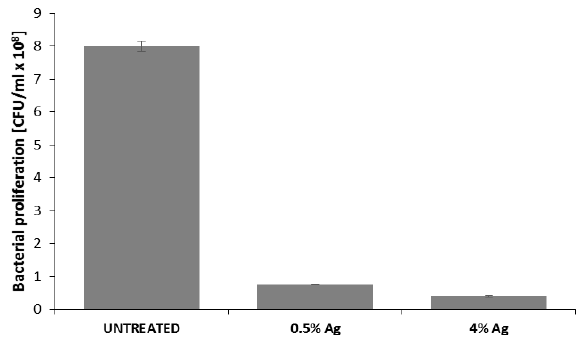
Figure 4. Quantification of bacterial biofilm on cotton gauzes through optical density measurements. Table 1. Quantification of bacterial biofilm on cotton gauzes through serial dilution method. Sample